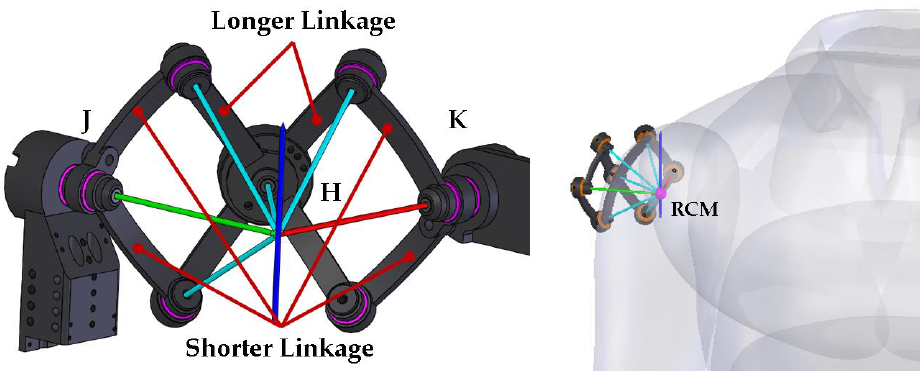
Figure 3. The CAD model of the spherical scissor mechanism.